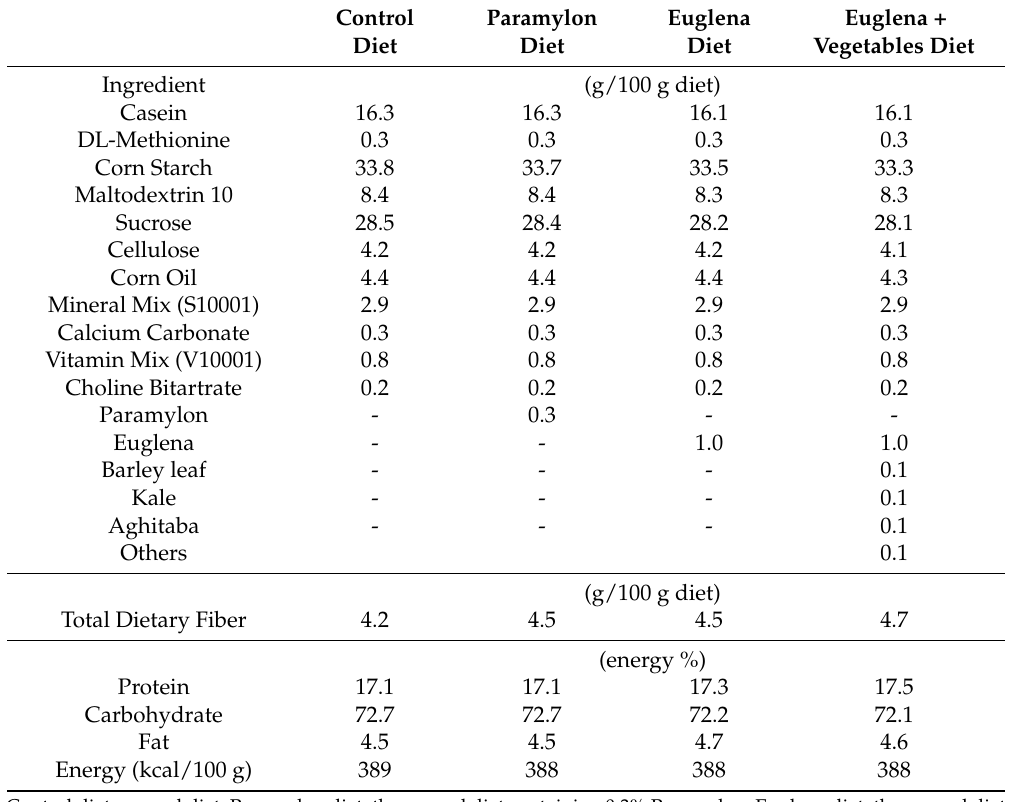
Table 1. Composition of test